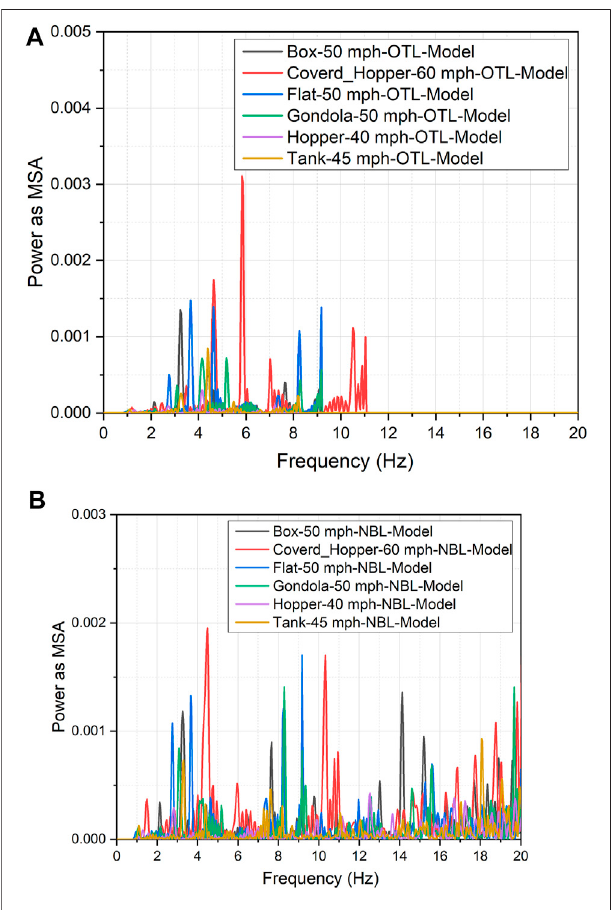
FIGURE 13 | Frequency domain analysis of tie acceleration under the passage of different freight train sets: (A) OTL; (B) NBL.